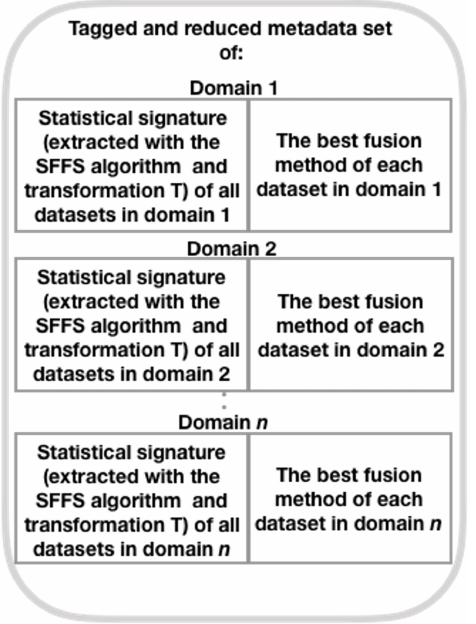
Figure 5. Reduced statistical signature labeling (adapted from Brena et al. [12]).